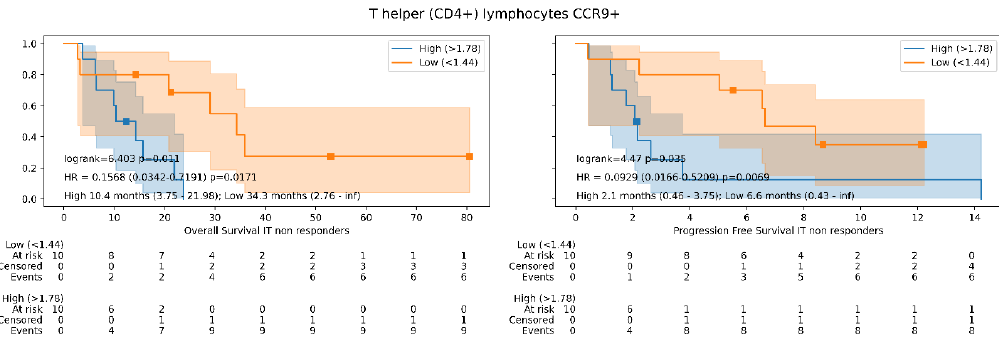
Figure 2. Overall survival and progression-free survival Kaplan–Meier curves showing overall survival differences in study group according to T-helper lymphocytes expressing CCR9 baseline levels in non-responder patients. The Kaplan–Meier curves show the differences in survival according the high or low expression of T-helper lymphocytes expressing CCR9 in the study group. In addition, the log-rank test, multivariate cox regression models, and the median of overall/progression-free survival and their range values are reflected.